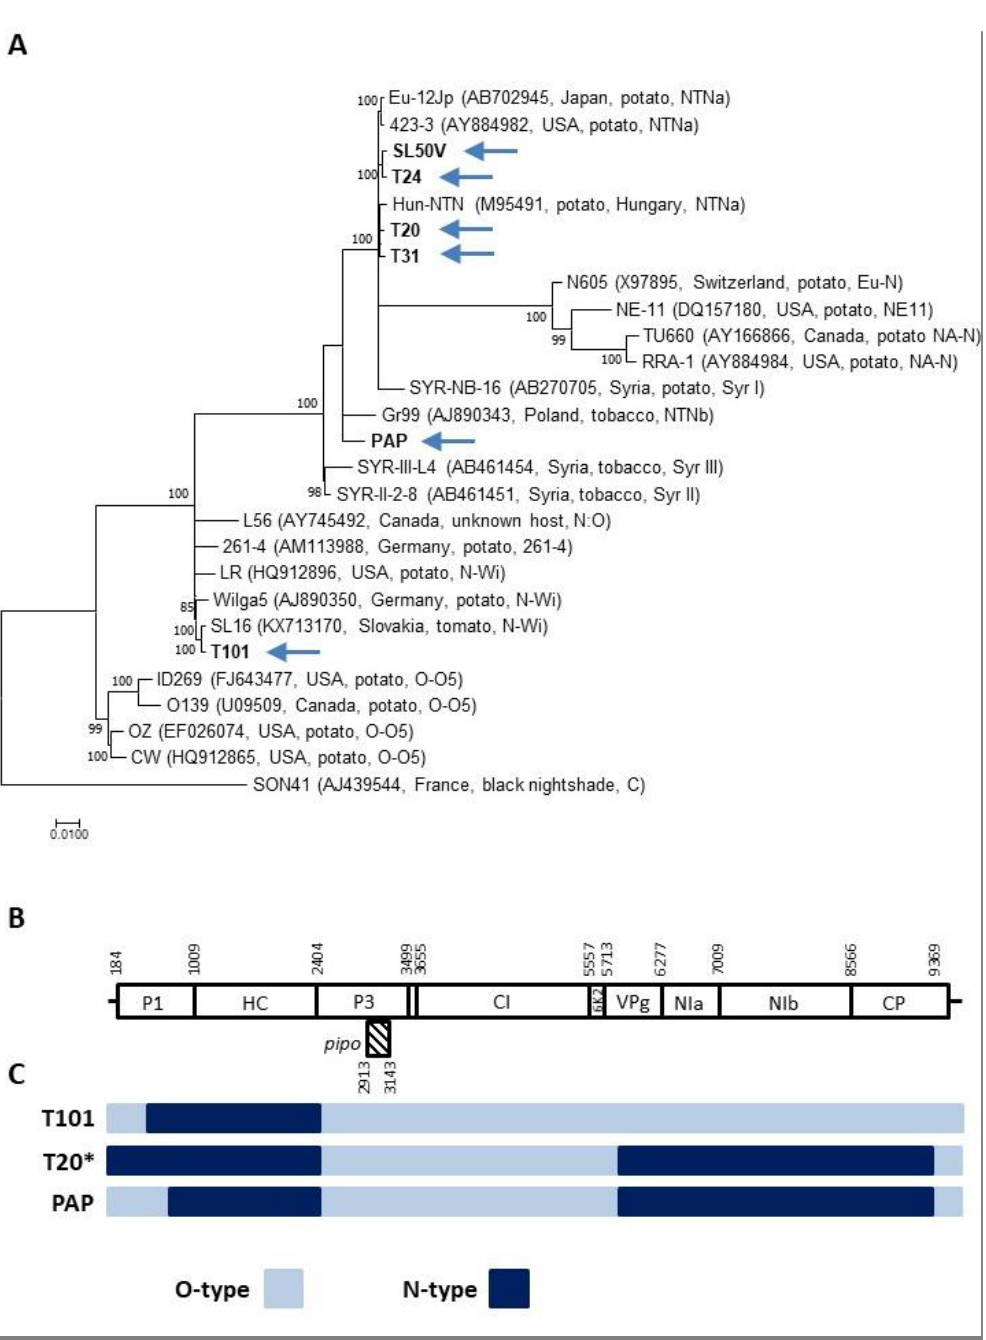
Figure 1. Analysis of samples showing single variant infections by PVY. ( A ) A maximum likelihood (ML) phylogenetic tree showing the relationship among PVY isolates. Complete genomes of PVY isolates determined in this work (highlighted by an arrow), together with sequences of the selected representing isolate belonging to different molecular groups, were used for phylogenetic analysis. The database isolates are identified by their names, GenBank accession number, country of origin, and strain relationship. Strain affiliation is indicated based on [20]. The phylogenetic analysis was inferred using maximum likelihood (ML) based on the General Time Reversible (GTR + G) model selected as the best-fit model of nucleotide substitution based on Bayesian information criterion (BIC) as implemented in MEGA 7. The divergent PVY isolate AJ439544 was used as an outgroup. Scale bar represents genetic distance and the numbers at the nodes indicate the bootstrap values (1000 replicates) >70%. ( B ) Schematic representation of the PVY genome showing the nucleotide positions delimiting the respective potyviral functional products (based on the complete genome of SL16 isolate (KX713170, PVY-N-Wi strain). ( C ) Schematic representation of recombinant PVY genomes isolates characterized in this work, showing the position of parental genome portions. PVY-O-type (azure), PVY-N-type (dark blue). * counts also for the T24, T31, PAP, SL50V, and PAR-P2 genomes.